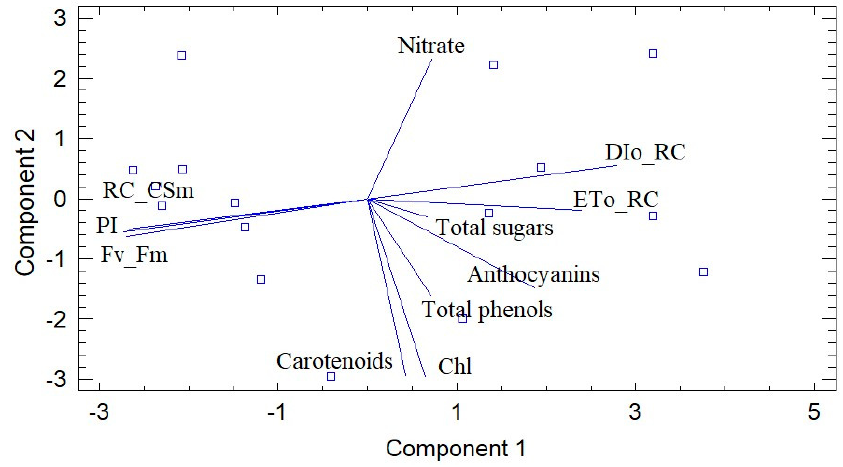
Figure 4. Biplot of principal component analysis results of all parameters measured in the two populations under two water regimes.